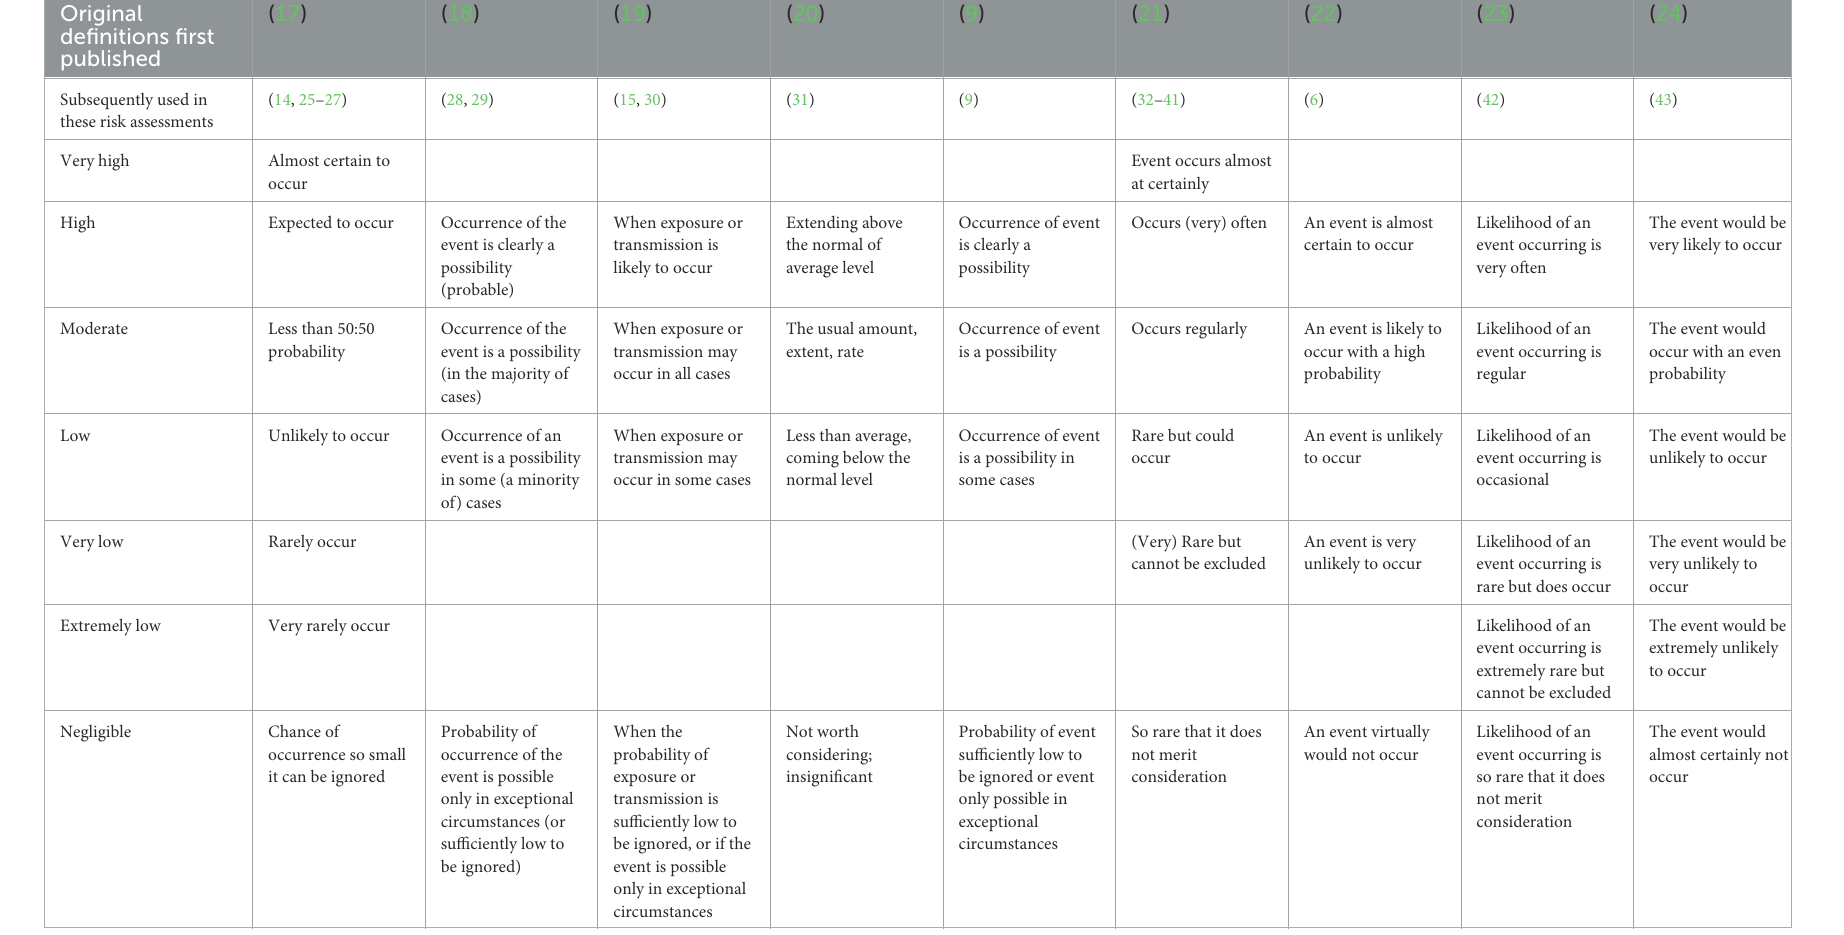
TABLE 1 Summary of the definitions of qualitative risk/probability levels used/defined in the papers selected through the literature